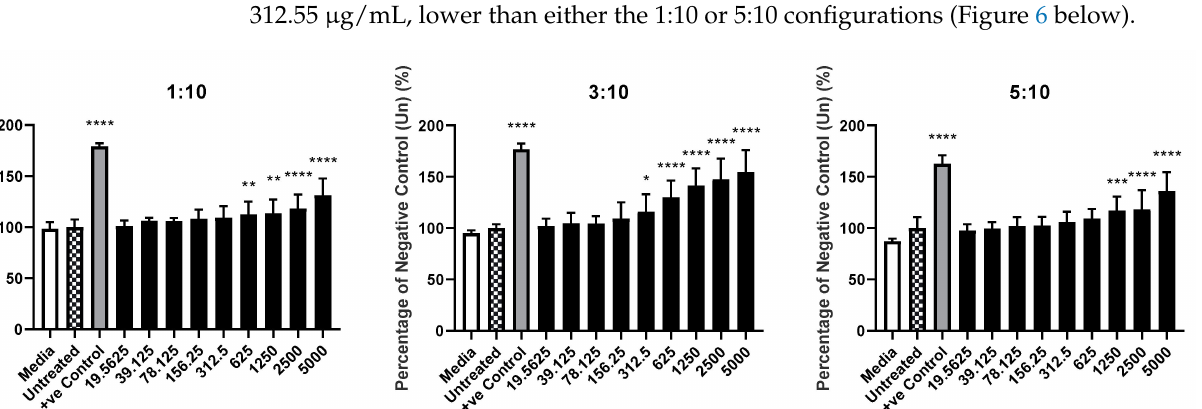
Figure 6. Investigation of cholesterol content and treatment concentration of materials upon cyto- toxicity via LDH assay. Level of mean absorbance measured at 492 nm, compared to that of the negative control (untreated), following 24 h incubation. Concentrations stated are as ng/mL. Values expressed as mean ( n = 8). * denotes p < 0.05. ** denotes p < 0.01. *** denotes p < 0.001. **** denotes p < 0.0001. White bar represents a cell-free, media-only control, chequered bar represents negative control (untreated), grey represents positive control, black represents treatments containing increasing concentrations of